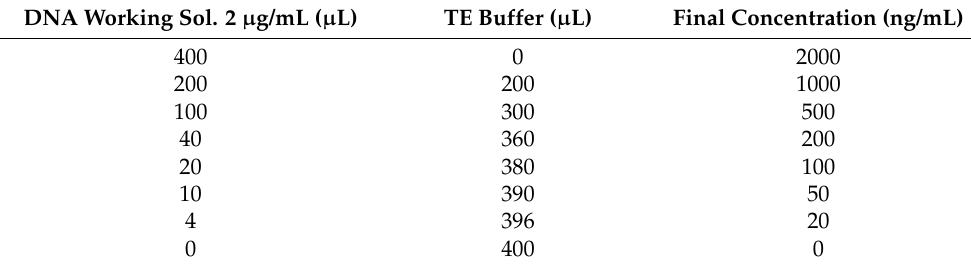
Table 5. Concentrations of DNA used to build the calibration curve. DNA Working Sol. 2 µ g/mL ( µ L) TE Buffer ( µ L) Final Concentration